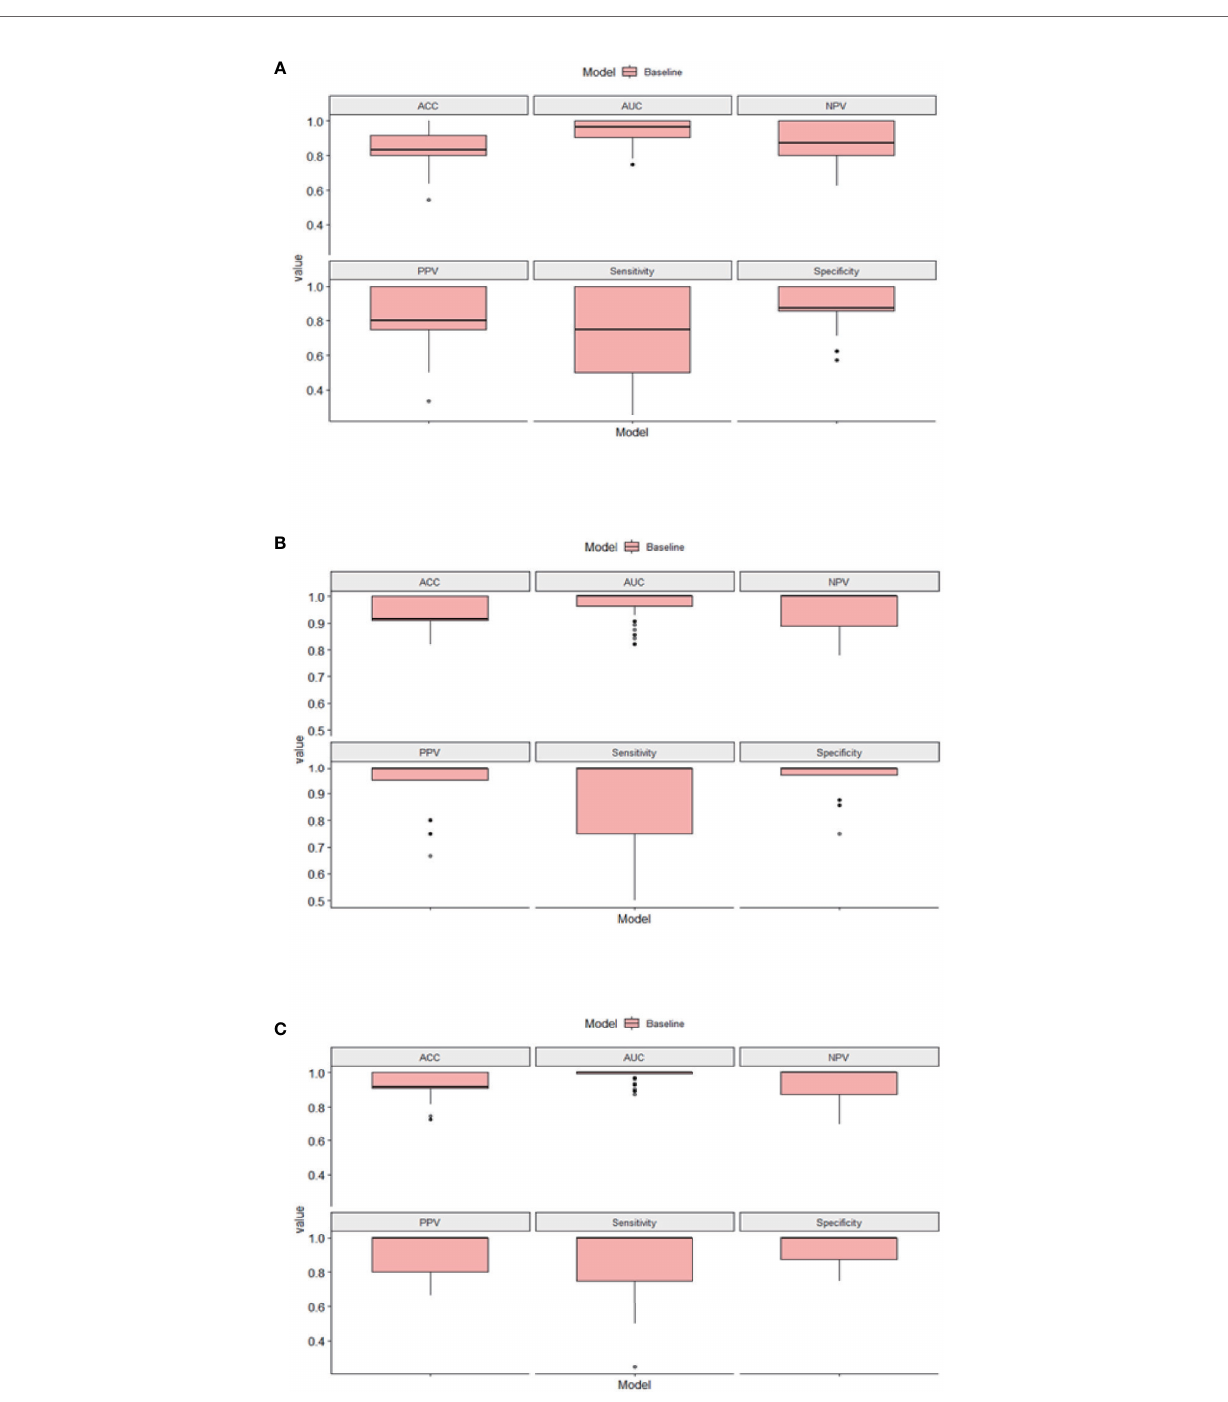
FIGURE 3 | The results of the 10 times 10-fold cross-validation of our models. (A) Box plots of logistic regression (LR). (B) Box plots of support vector machine (SVM). (C) Box plots of random forest (RF). ACC, accuracy; AUC, area under the curve; NPV, negative predictive value; PPV, positive predictive